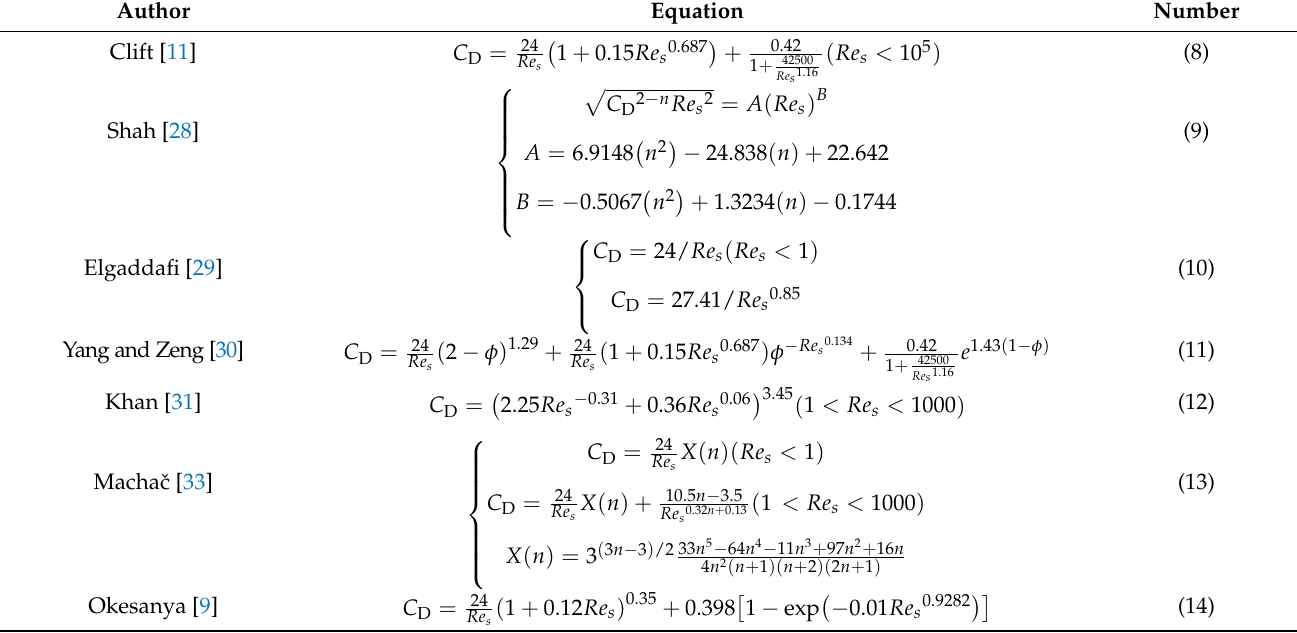
Table 3. Representative C D - Re s